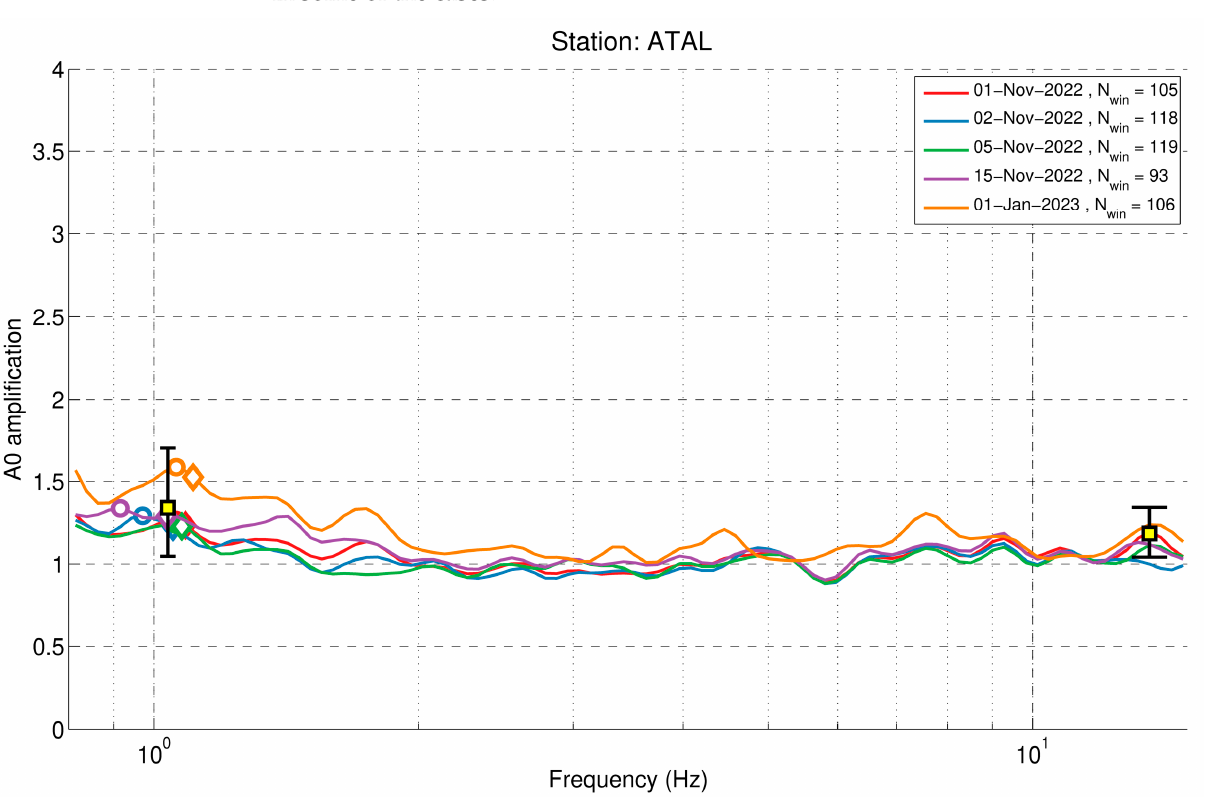
Figure 15. Location of the seismological station ATAL and the geophysical measurements along with the geology of the area.